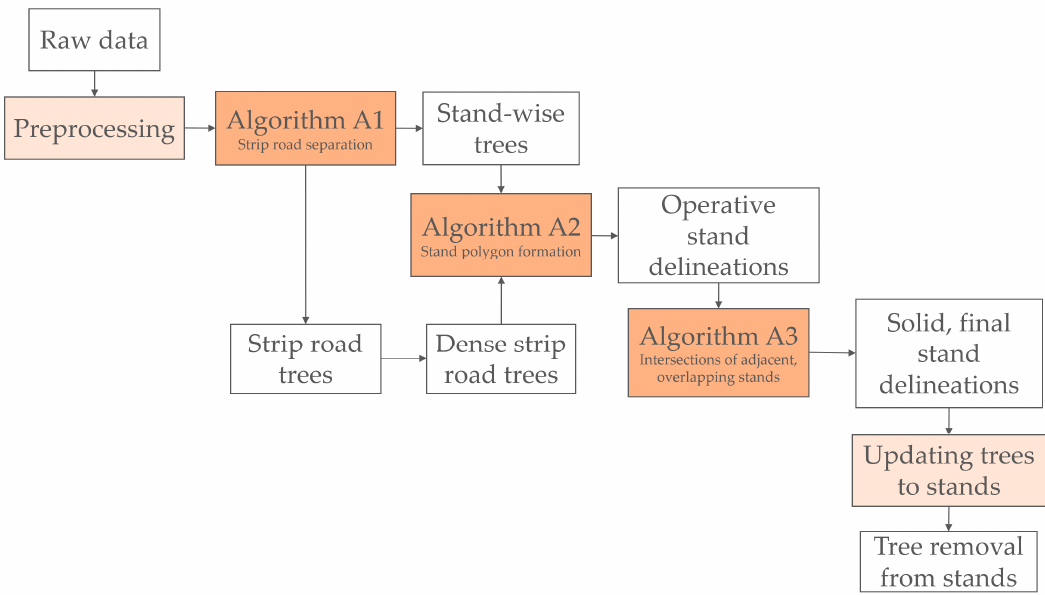
Figure 2. The workflow of geoprocessing in automated stand delineation.